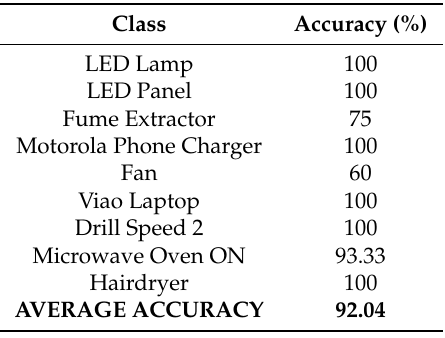
Table 5. Inference accuracy of target load generated using GAN.